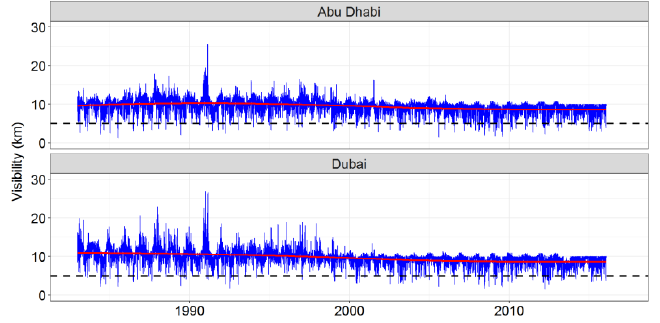
Figure 2. An illustrative example of long-term averaged daily visibility observations for two stations, Abu Dhabi and Dubai, during the period of 1982–2016. The dashed line shows the 5 km threshold. Visibility trends at Abu Dhabi airport during months with records below the annual average (low visibility months) and above the annual average (high visibility months) are shown in Figure 3.